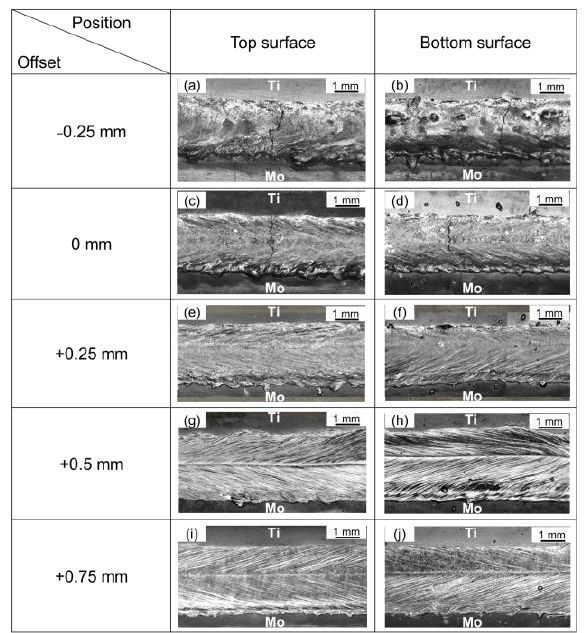
Figure 4. Effects of laser beam offset on the surface morphologies of Mo/Ti joints. ( a , c , e , g , i ), the top surface morphologies of welded joints under the offsets of − 0.25 mm, 0 mm, +0.25 mm, +0.5 mm, +0.75 mm respectively; ( b , d , f , h , j ), the bottom surface morphologies of welded joints under the offsets of − 0.25 mm, 0 mm, +0.25 mm, +0.5 mm, +0.75 mm respectively.